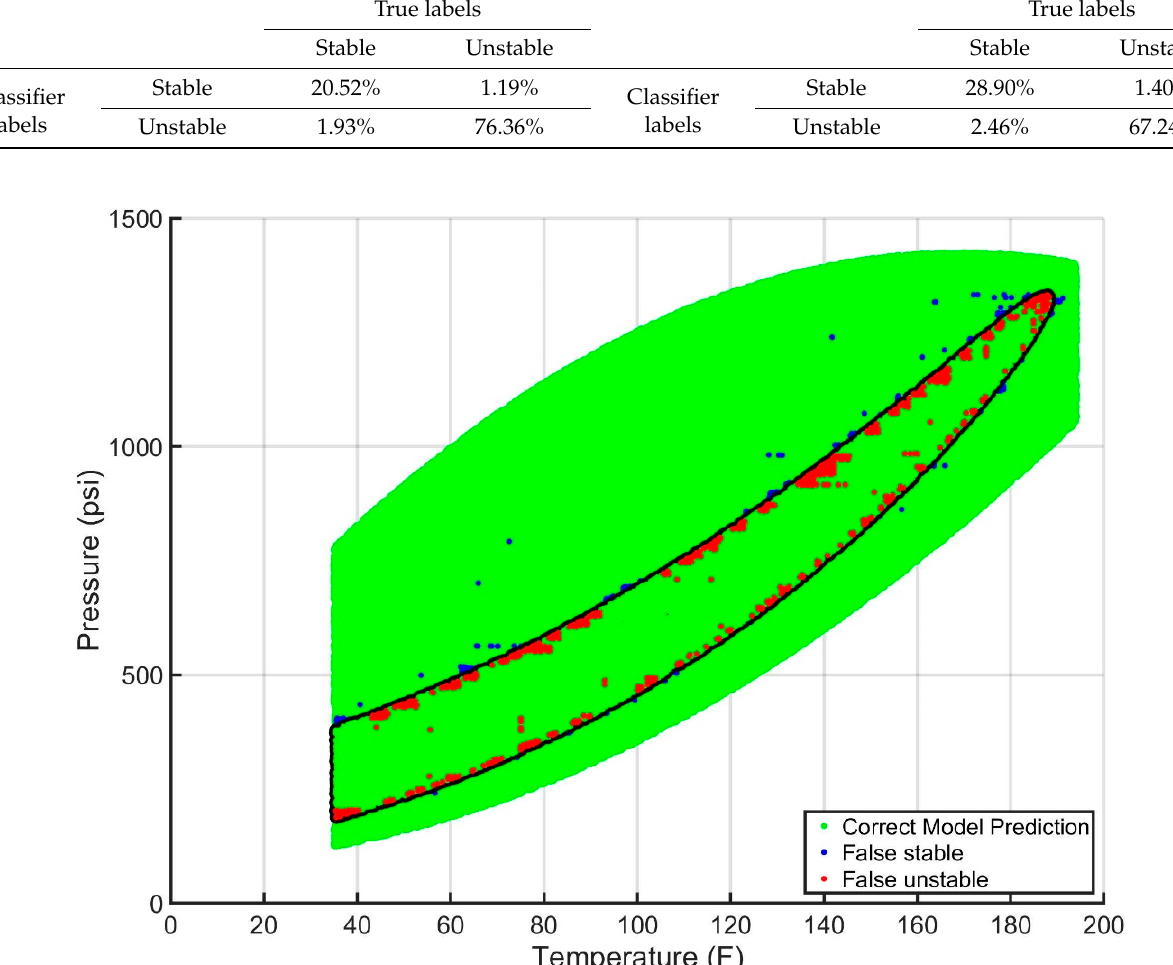
Figure 5. Visualization of the decision tree model results on testing datapoints.